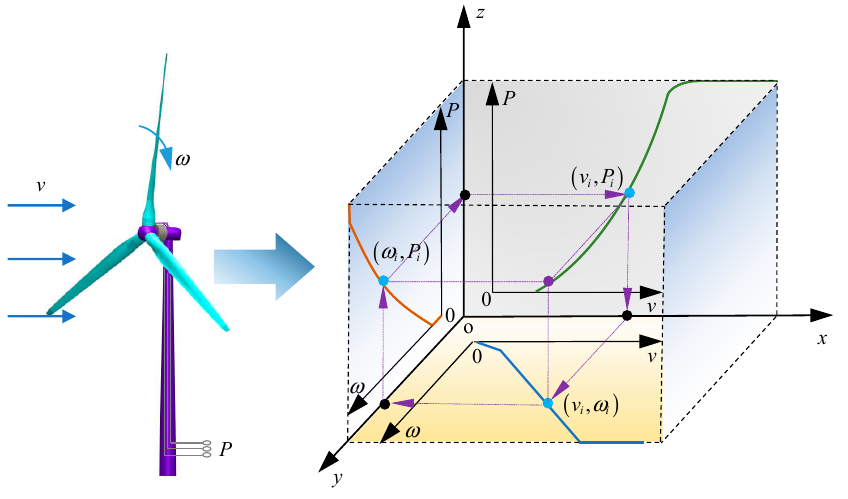
Figure 1. Wind turbines and performance curves.